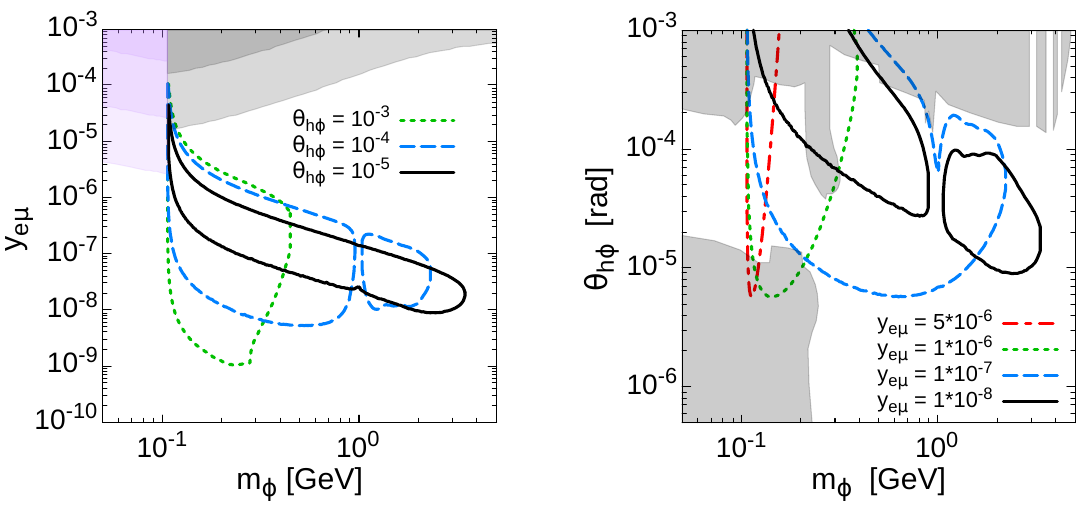
Figure 1 . The contour plots of 95 % C.L. sensitivity regions for the scalar-type interaction in the m φ − y eµ plane (left) and the m φ − θ hφ plane (right). Left: the purple shaded areas are excluded by E137 for θ hφ = 10 − 3 (light), 10 − 4 (medium), and 10 − 5 (dark). The gray shaded areas are excluded by µ → eγ for θ hφ = 10 − 3 (light) and 10 − 4 (medium). Right: the gray shaded areas show the current exclusion regions for the dark-Higgs